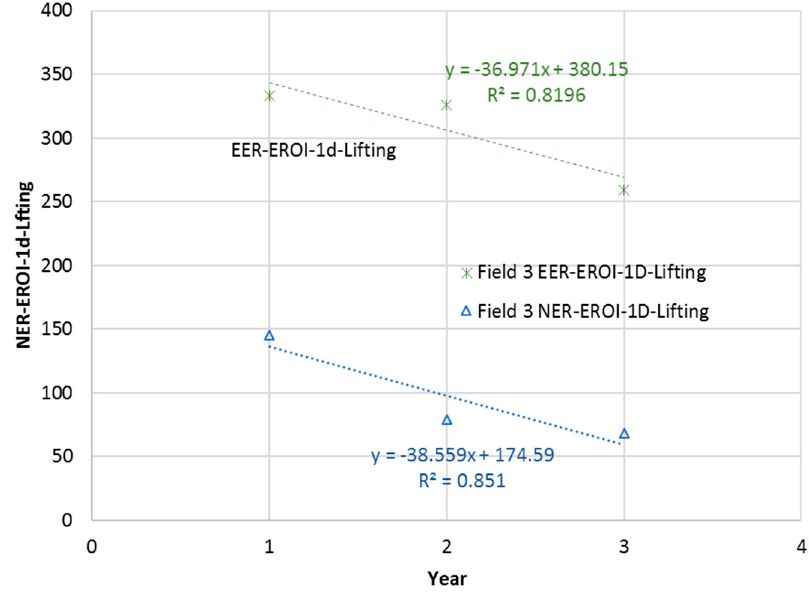
Figure 10. Comparison of NER-EROI-1d Lifting vs. EER-EROI-1d Lifting for Field 3.